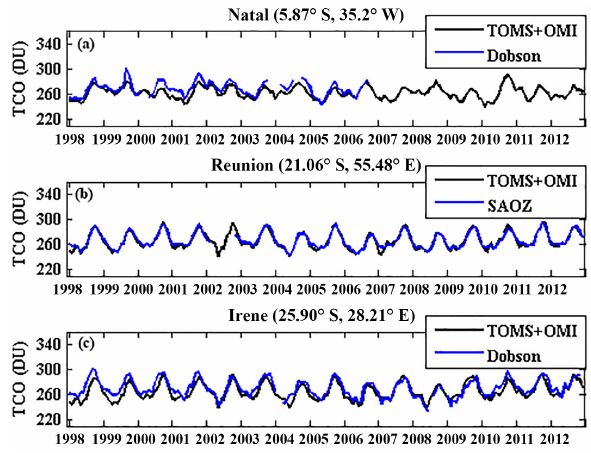
Figure 3. Temporal evolution of TCO from ground-based spec- trometers (blue) compared with that obtained by a combination of TOMS and OMI TCO overpass over Natal (a) , Reunion (b) and Irene (c) for the period January 1998 to December